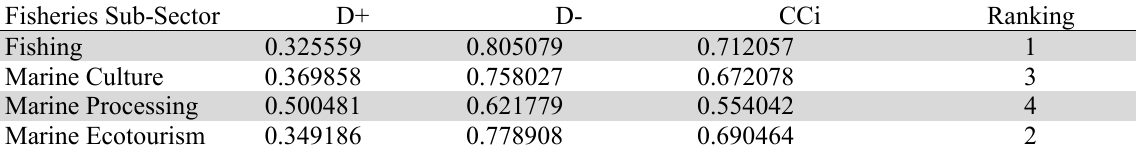
Distance, Closeness coefficient (CCi) and final ranking of the fisheries sub-sector of Kei Kecil Sub-